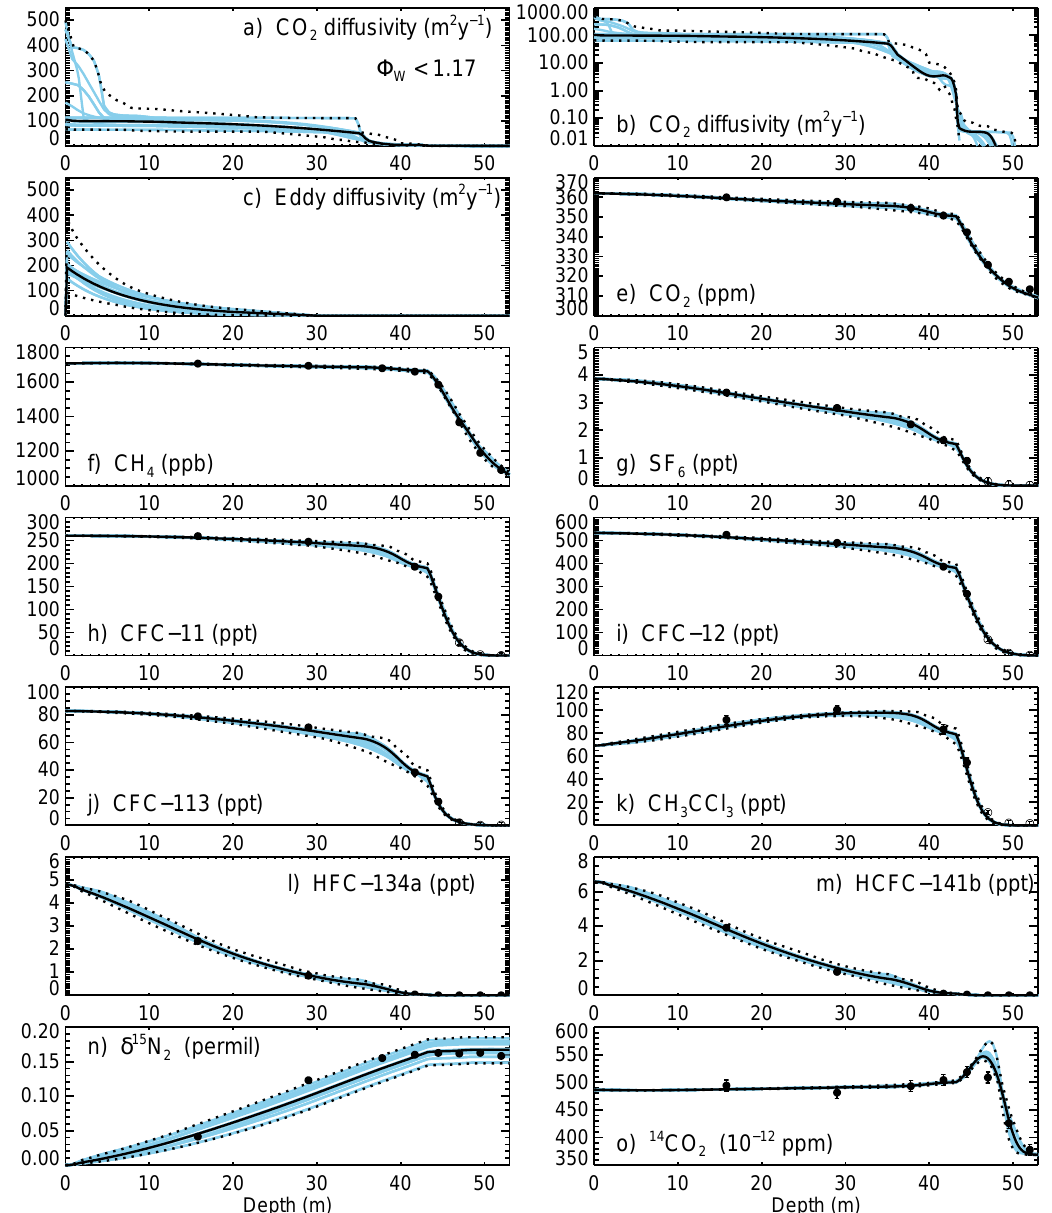
Fig. 10. Diffusivity and tracers at DSSW20K for 8 W < 1 . 17. This case has exponentially-decreasing eddy diffusion for convective mixing near the surface until 30m then linear decrease to zero. Solid circles show observations used for calibration, open circles show additional measurements that were not used for